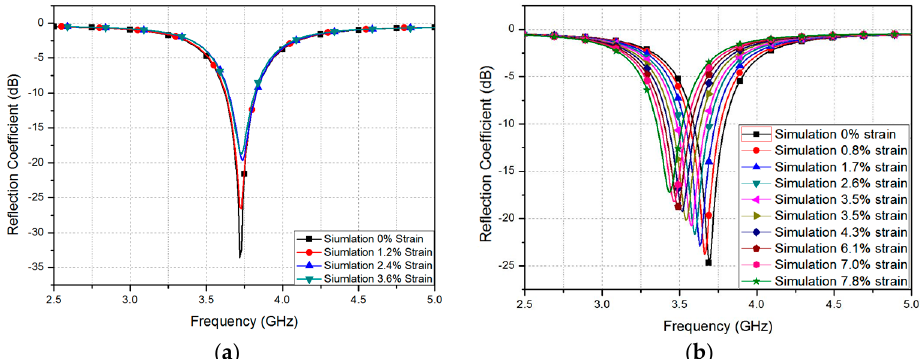
Figure 3. Simulated reflection coefficients at different patch ( a ) widths and ( b ) lengths.